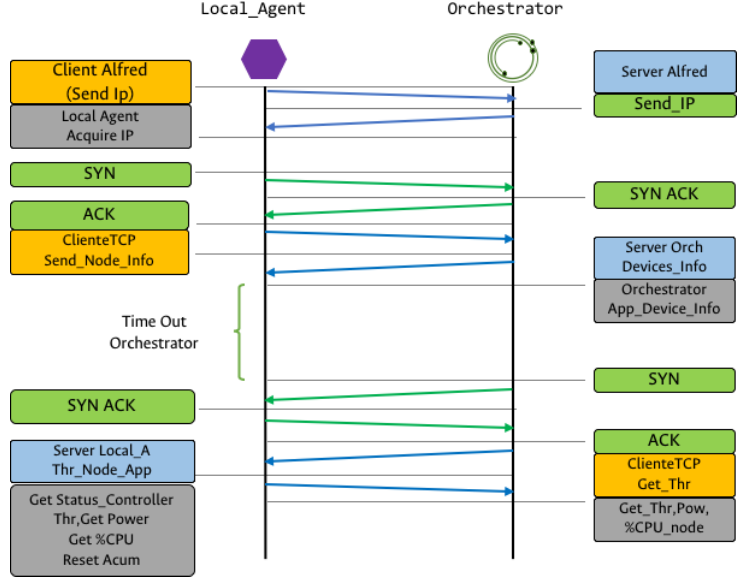
Figure 4. Local Agent-Orchestrator Communication.